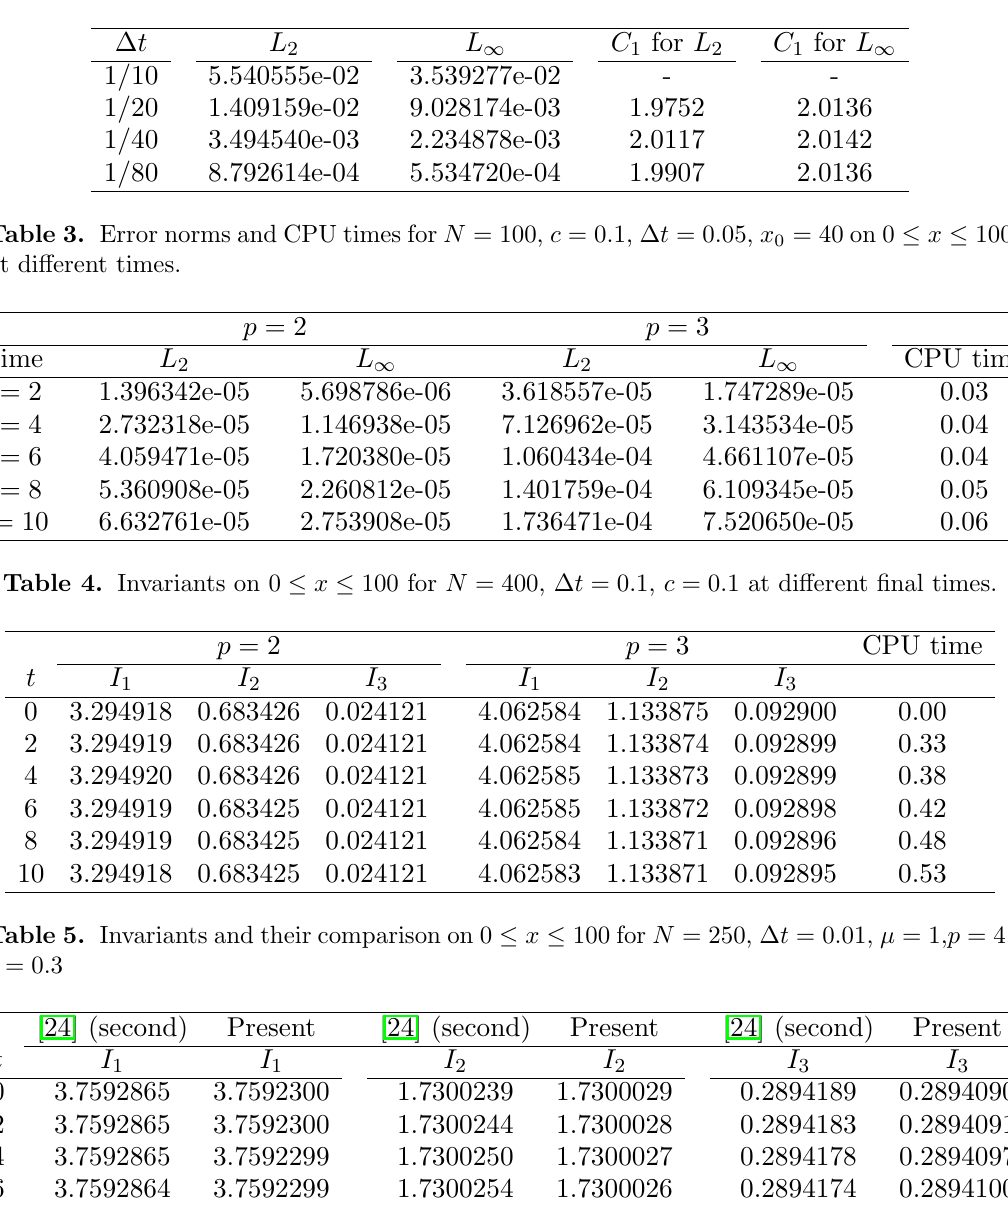
Table 2. Error norms and convergence orders for c = 4 / 3, p = 4 and decreasing values of ∆ t at t = 1.